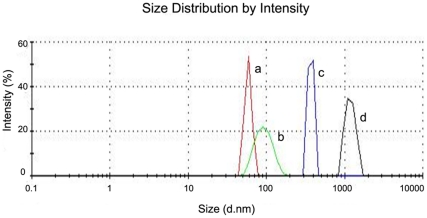
Malvern Zeta sizer analysis of drug loaded liposome.The values reported are after 12 weeks of storage at 4°C with drug/lipid mole ratio (size, nm) (a) 0.044 (63±10), (b) 0.11 (90±30), (c) 0.18 (200±80) and (d) 0.37 (1250±200). Size measurement reported here are mean of three batches and the standard deviations (±) are expressed inside bracket.